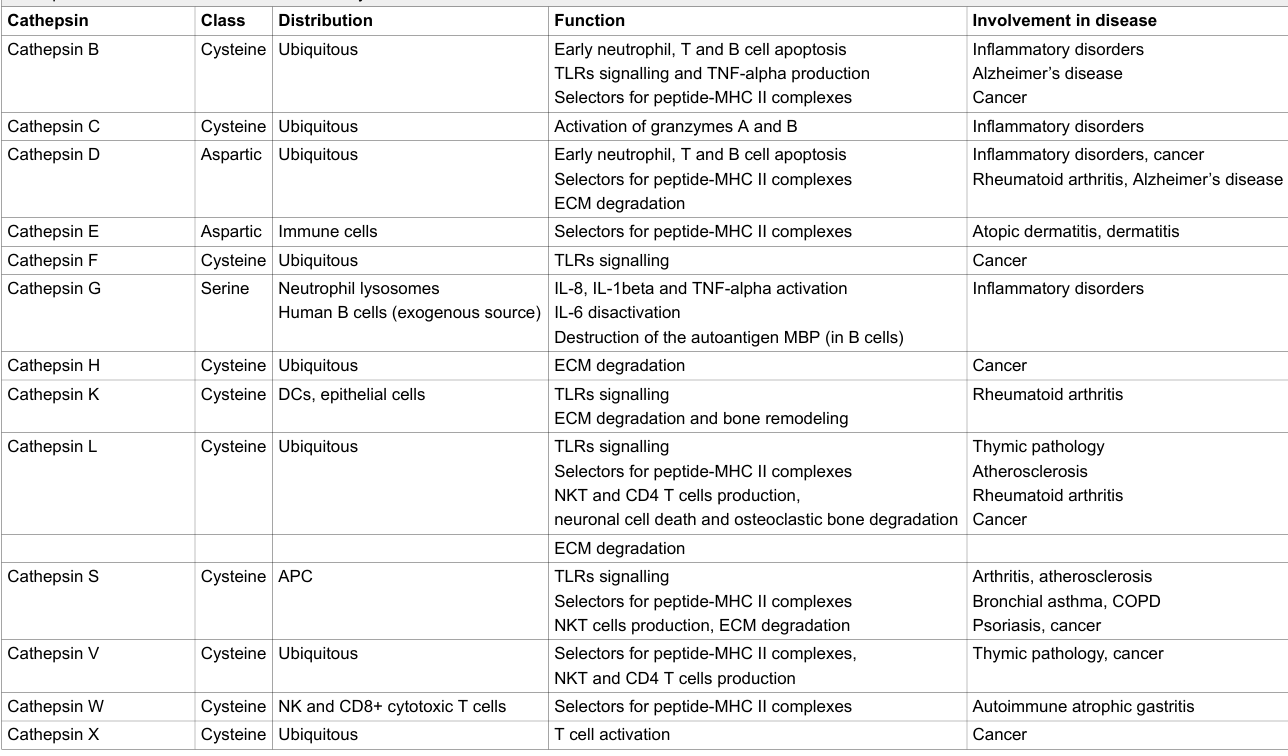
Table 1 Cathepsins and their functions in the immune